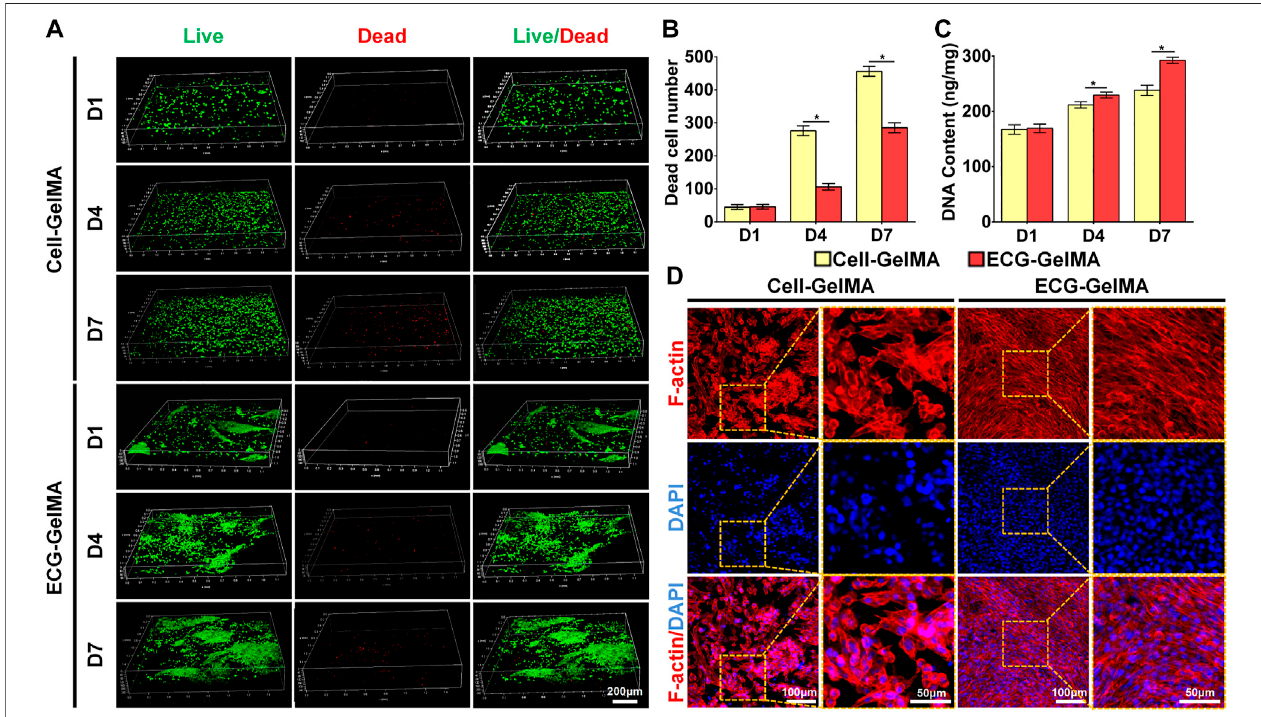
FIGURE3 | Biocompatibility evaluationofCell-GelMAand ECG-GelMA. Live/dead stainingimages (A) ,as well asquantitativeanalysisofdead cell number (B) and DNA content (C) in Cell-GelMA and ECG-GelMA groups at 1 – 7 days. Phalloidin staining images in Cell-GelMA and ECG-GelMA groups at 7 days (D) . * p < 0.05.